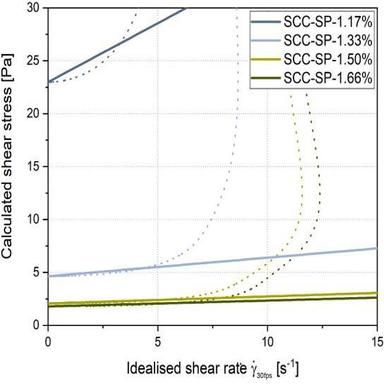
Flow curve of SCC-SP-X mixes, with an idealised shear rate based on 30 fps and a linear regression (fixed intercept at yield stress) of the measuring points located between yield stress and lowest apparent viscosity.